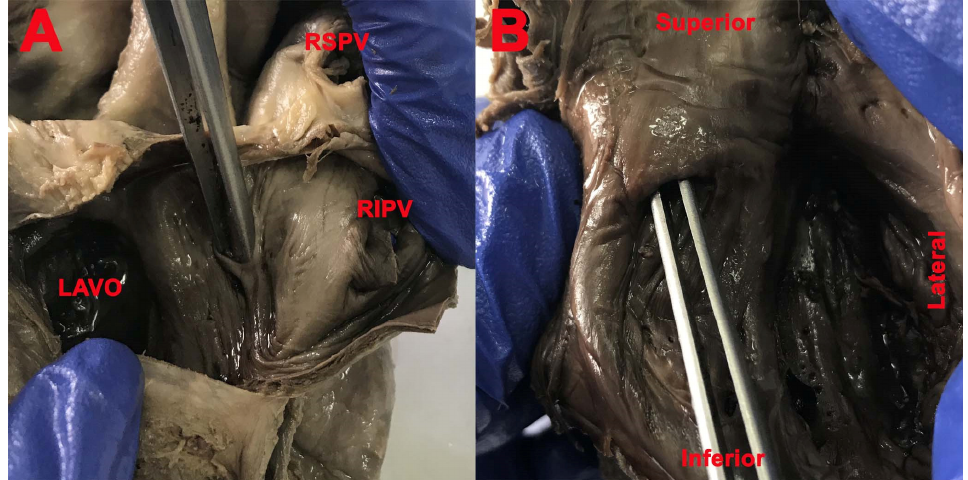
Figure 3. ( A , B ) SP (lifted by clip). ( A ): LAVO —left atrioventricular orifice; RSPV —right superior pulmonary vein; RIPV —right inferior pulmonary vein.